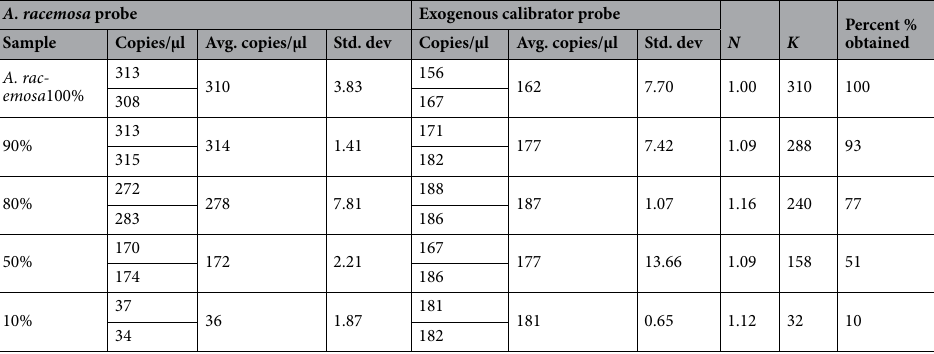
Table S6). From the results obtained, the proposed quantification method is highly applicable to commercial samples. The measured value for the sample CS4 was 33% (see Supplementary Table S5) and 32% (see Supplementary Table S6) using the LC-480 and bCUBE platforms, respectively. The deviation of the sample CS4 from the original ratio of 28% was observed to be 18% and 11% using LC480 and bCUBE platforms, respectively. dPCR.